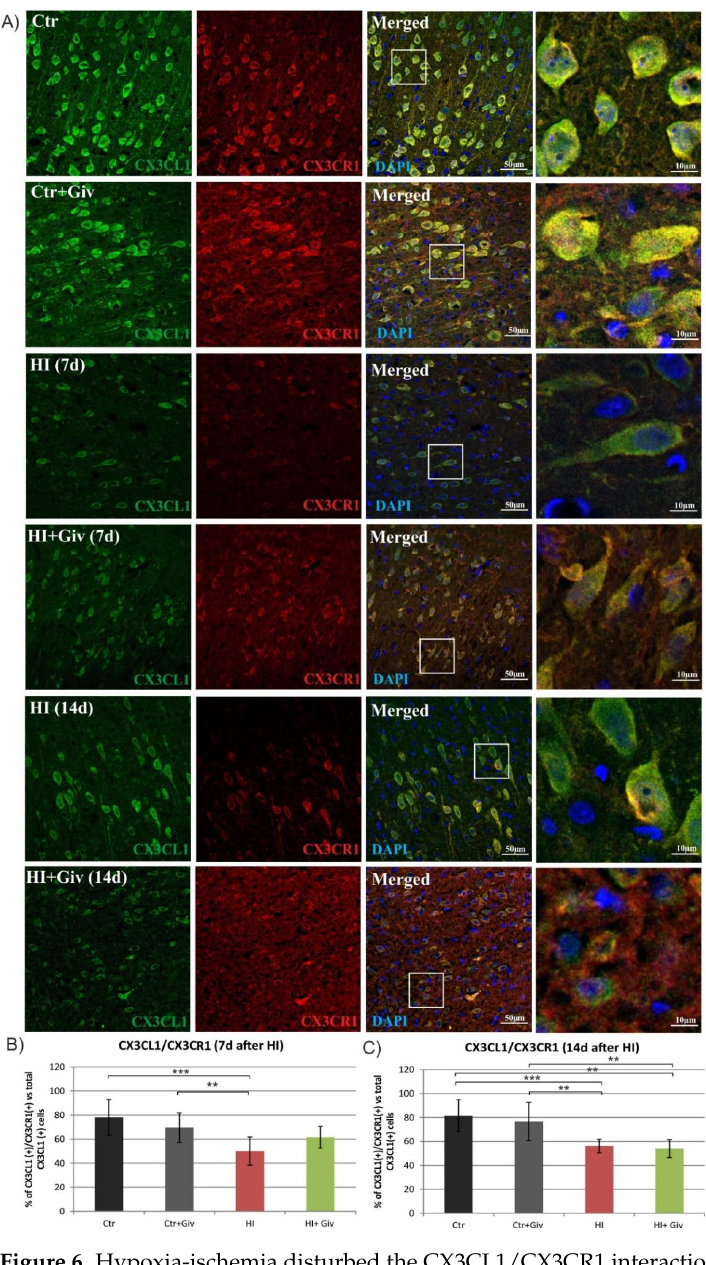
Figure 6. Hypoxia-ischemia disturbed the CX3CL1/CX3CR1 interactions. Sections from ipsilateral (hypoxic-ischemic) hemispheres 7 and 14 days after HI were stained for CXC3L1 antibody (green) and for its receptor CX3CR1 (red) ( B ). Nuclei were labeled with DAPI (blue). ( A ) Representative photomicrographs show colocalization of CX3CL1/CX3CR1 (yellow) in the cortex. Enlargements present areas marked in rectangles. Number of CX3CL1/CX3CR1-positive cells quantified in the brain cortex area (0.36 mm 2 ) 7 days ( B ) and 14 days (C) after HI. Note the significant decrease in double-stained cells 7 and 14 days after HI regardless of Givinostat treatment. The values are means ± SD from five animals per group. One-way ANOVA indicates significant differences between the investigated experimental groups: ** p < 0.01; *** p <